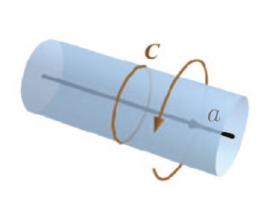
Figure 8 . The Dehn twist along the non-contractible loop C only yields a U(1) phases e i 2 (cid:25)h a that depends on the label a